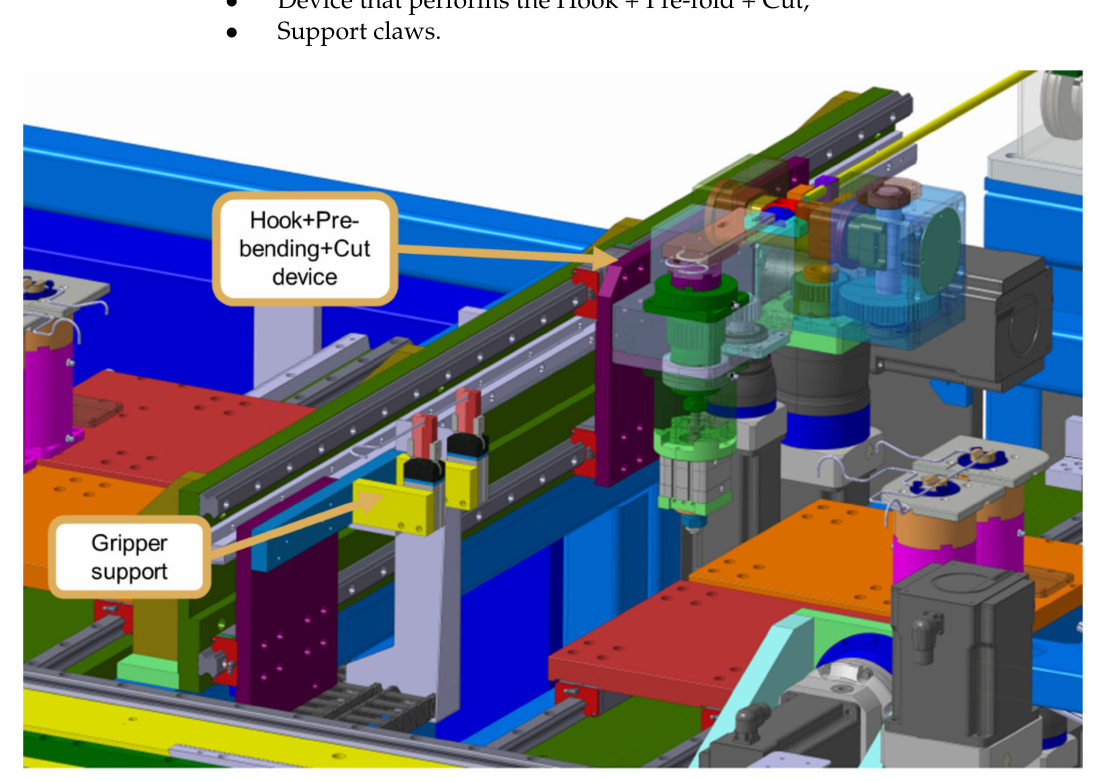
Figure 21. Central station.